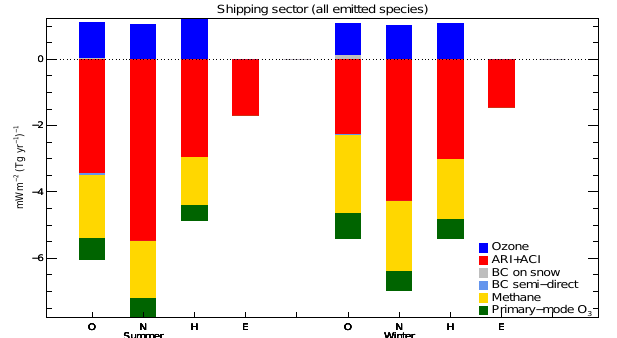
Figure 5. Specific radiative forcing, in mWm − 2 (Tgyr − 1 ) − 1 , for seasonal reductions in all the species emitted by the shipping sec- tor. The species included and their units of emitted mass are sul- fur dioxide (SO 2 ), black carbon (BC), organic carbon (C), am- monia (NH 3 ), nitrogen oxides (NO 2 ), volatile organic compounds (VOCs), carbon monoxide (CO), and methane (CH 4 ). Results are obtained by four global models: OsloCTM2 (O), NorESM1 (N), HadGEM3 (H), and ECHAM6 (E). Six categories of radiative forc- ing mechanisms are included: aerosol–radiation and aerosol–cloud interactions (red, except for ECHAM6 which diagnoses aerosol– radiation only), black carbon deposition on snow (grey, OsloCTM2 only), black carbon rapid adjustments from the semi-direct effect (light blue, OsloCTM2 only), short-term changes in ozone (dark blue, not simulated by ECHAM6), methane (yellow, not simulated by ECHAM6), and primary-mode ozone (green, not simulated by